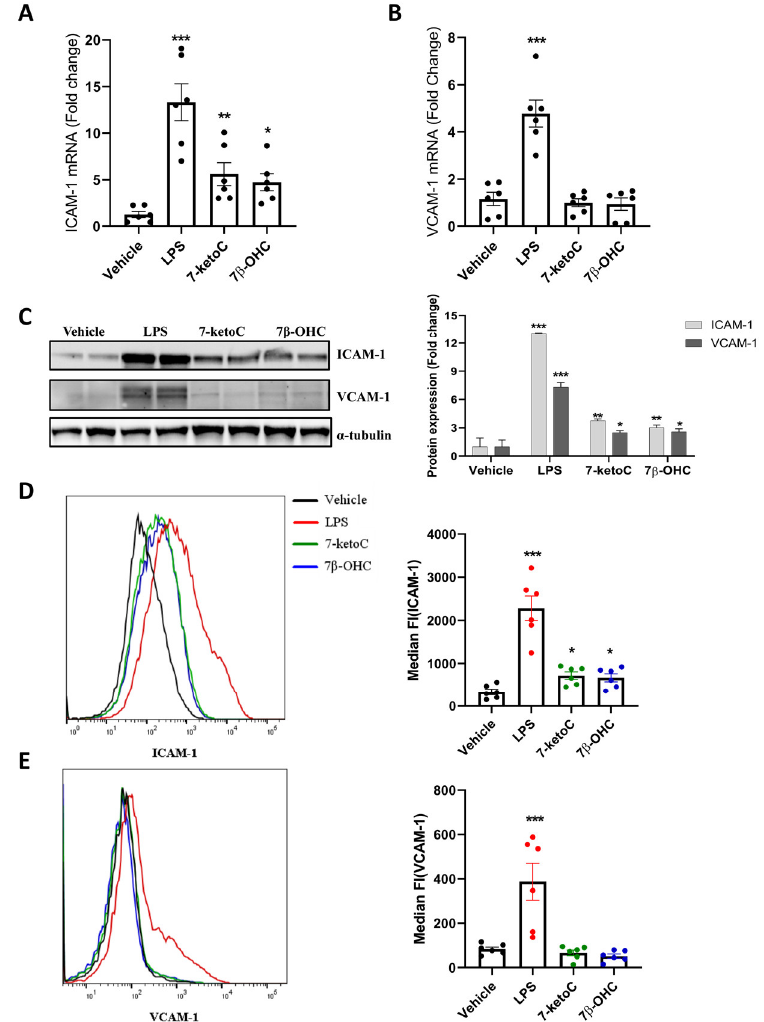
Figure 3. ICAM-1 but not VCAM-1 expression is enhanced by oxysterols. Treatment with 7-ketoC or 7 β -OHC (10 µ m) for 24 h significantly augments ICAM-1 ( A ) but not VCAM-1 ( B ) mRNA in fpEC ( n = 6). LPS (100 ng/ µ L) served as the positive control. ( C ) Total cellular ICAM-1 protein is significantly induced by oxysterols. ( D ) Cell surface staining followed by FACS analysis of oxysterol- treated cells reveals significant induction of ICAM-1. ( E ) LPS but not oxysterols induce surface localization of VCAM-1. Statistically significant differences between vehicle and oxysterol treatment group were calculated using one-way ANOVA, followed by Dunnett’s post hoc test. Data are presented as mean ± SEM * p < 0.05, ** p < 0.01 and *** p <